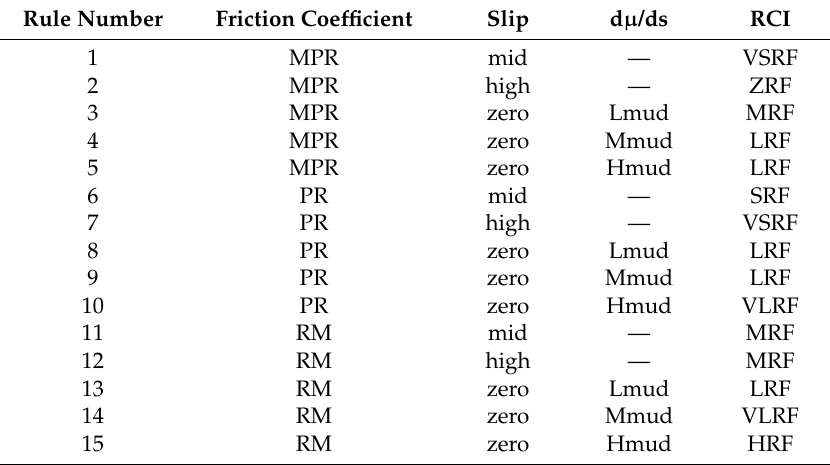
Table 2. Road control rules.